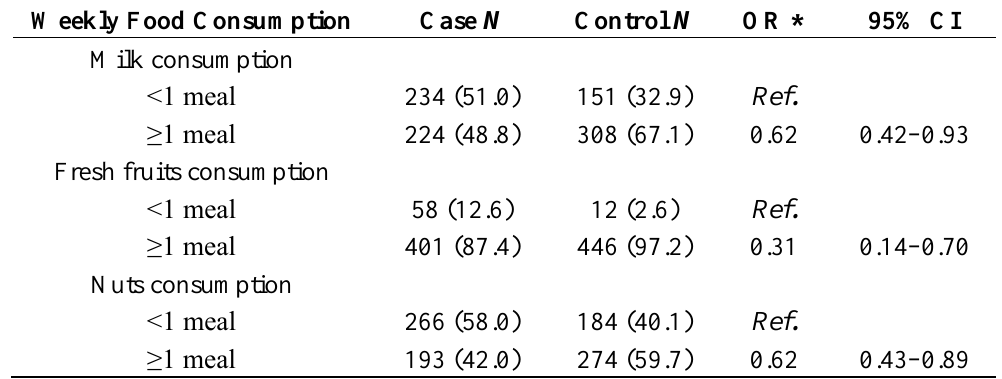
Table 3. Multivariate analysis of association between weekly food consumption and NTDs